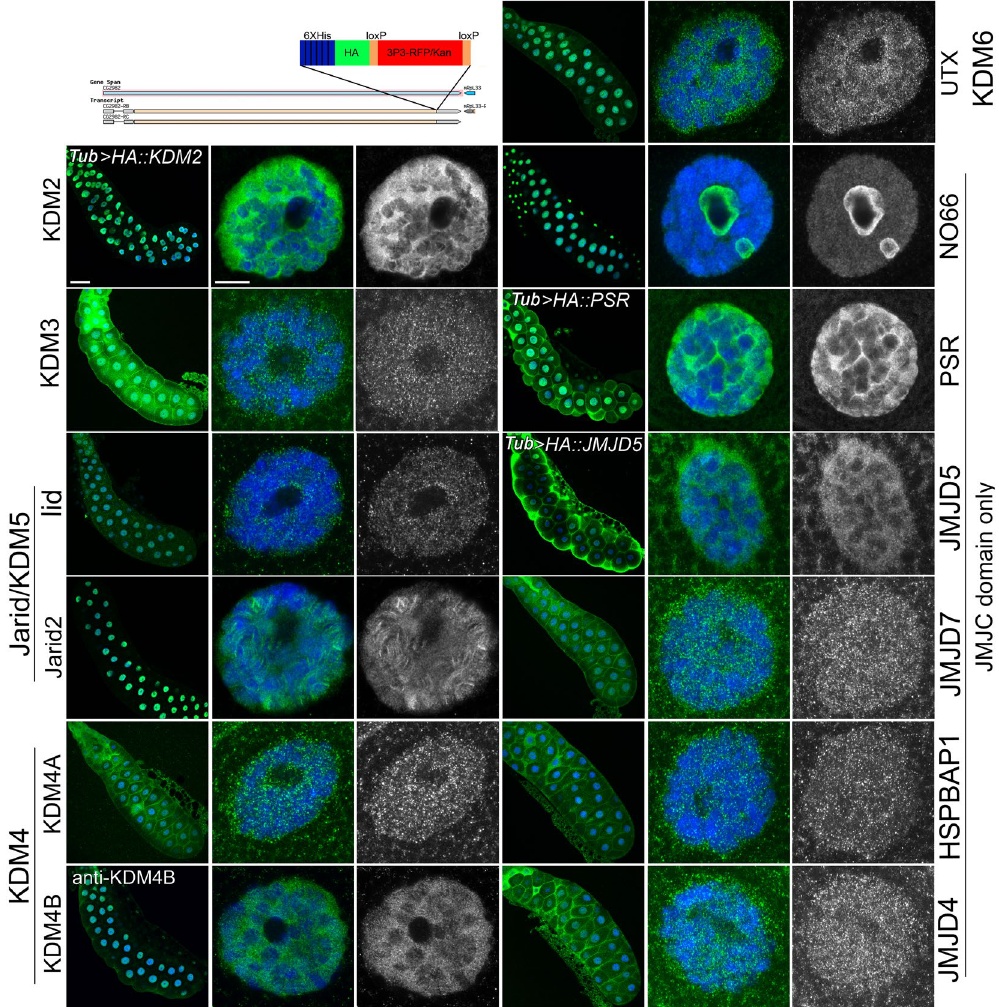
Figure 2. Subcellular localization of Drosophila JmjC proteins. The top left panel is a sketch of the cassette inserted into 3 ′ end of the JmjC genes to generate a 6xHis-, HA-, C-terminal tag, followed by an RFP-cassette flanked by two loxP sites. The RFP-cassette consists of eyeless promoter-driven RFP and Kanamycin. This cassette was removed by crossing the lines to a source of Cre, leaving a 34 bp loxP site between the HA tag and 3 ′ UTR. For all subsequent rows in the figure, the gene is indicated on the side. Salivary glands were stained with HA (green; and in greyscale in third and sixth column), counterstained with DAPI for DNA (blue), and whole glands and single cells are shown. Scale bar is 20 μ m for the entire salivary gland image and 2 μ m for the single cell image. In three cases (KDM2, PSR and JMJD5) the genomic tag exhibited weak to no expression, therefore the UAS-tagged line was used instead, driven by the ubiquitous driver, tubulin ( tub ) -Gal4 . In one line, KDM4B::HA, anti-KDM4B was used instead of